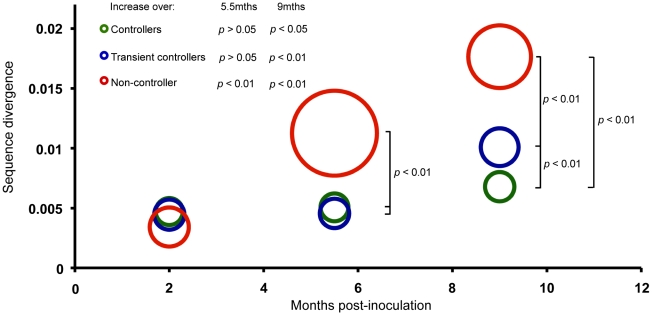
Sequence divergence from SIVmac239 in controller, transient-controller and non-controller macaques.Full-length envs were isolated and sequenced from 12 macaques at 2, 5.5 and 9 months p.i. with SIVmac239. The level of sequence divergence from the inoculate strain was estimated from the phylogeny under the CTR+γ+I model. For each group of macaques (LC, TC and NC), the mean of divergence (position of circle centre on y axis) and the mean of diversity (radius) is represented here. Mean divergence increased significantly over time in all macaque groups (5.5 months: LC p>0.05, TC p>0.05, NC p<0.01; 9 months: LC p<0.05, TC p<0.01, NC p<0.01) as determined by two-sample T-tests (with Welch approximations for degrees of freedom). Mean divergence differed significantly between groups of macaques at 5.5 months (LC vs NC: p<0.01; TC vs NC: p<0.01) and 9 months (All groups: p<0.01) p.i. Sequences from macaque NC3 were significantly more diverse than those of LC and TC macaques at the 5.5 (p<0.05) and 9 (p<0.01) month time points.